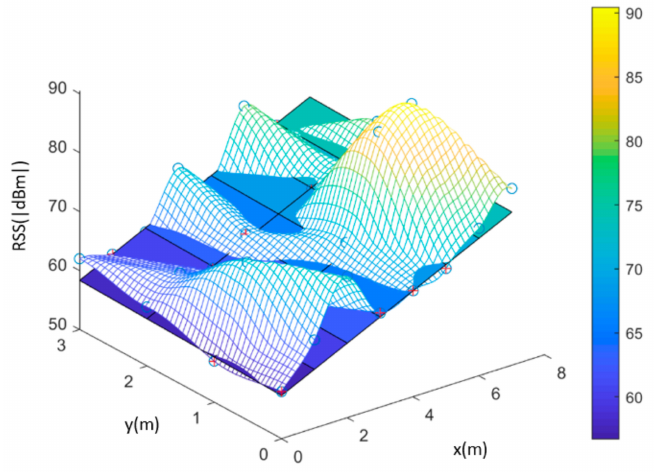
Figure 3. Actual Signal Intensity Distribution and the Planar